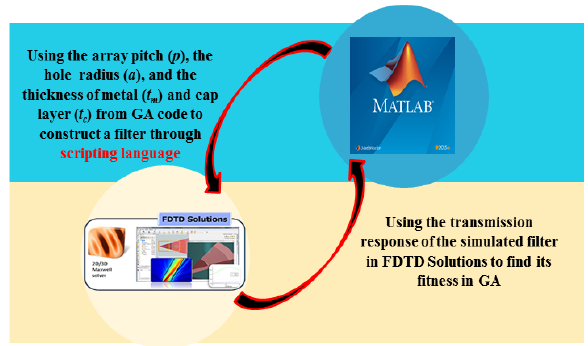
Figure 2. The optimization procedure by integrating GA with FDTD